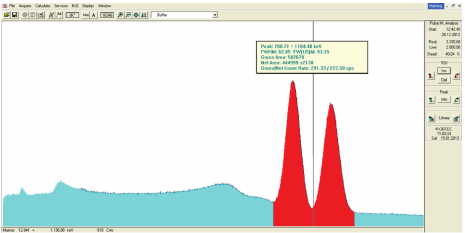
Figure 3: Gamma ray spectrum obtained from 60 Co source.